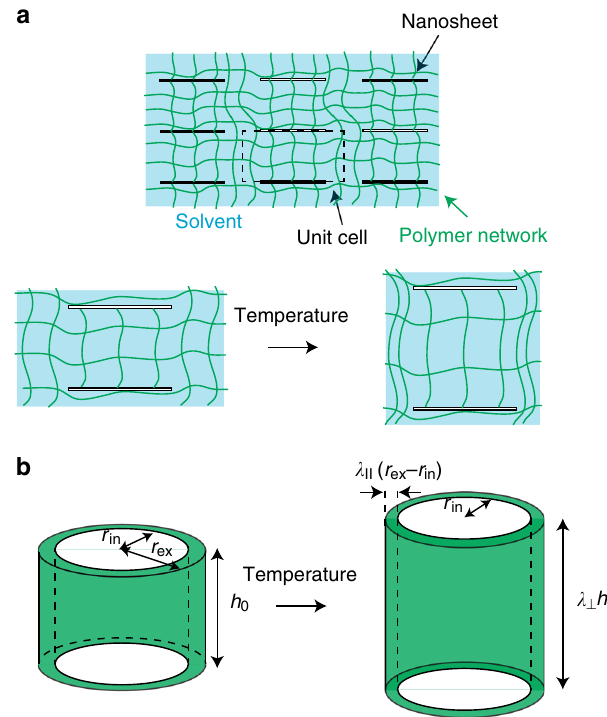
Fig. 1 A model of a composite gel. a The side view of a composite gel, in which solid nanosheets (shown by white rectangles) are immobilized by a polymer network (green lines) in a solvent (light blue background). The nanosheets are cofacially oriented and are aligned periodically. b The composite gel is a treated as an assembly of unit cells, which are composed of the central region of radius r in , sandwiched by the two registered nanosheets, and the surrounding region of thickness r ex − r in . Each unit cell is a cylinder of a radius r ex and the height h 0 . The thickness r ex − r in of the surrounding region and the distance h 0 between the nanosheets are smaller than the radius r in of the nanosheets. The central region can deform in the direction normal to the nanosheets (with an extension ratio λ ⊥ ), but cannot deform in the lateral direction. The surrounding region can deform freely in the radial direction (with an extension ratio λ || ) and can deform in the normal direction with the same extension ratio as the central region.